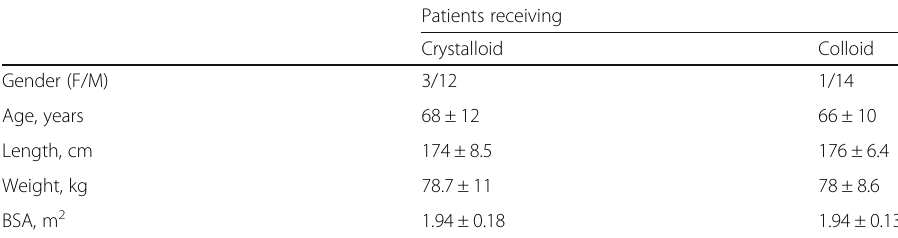
Table 1 Demographics, mean and standard deviation (SD) of patients